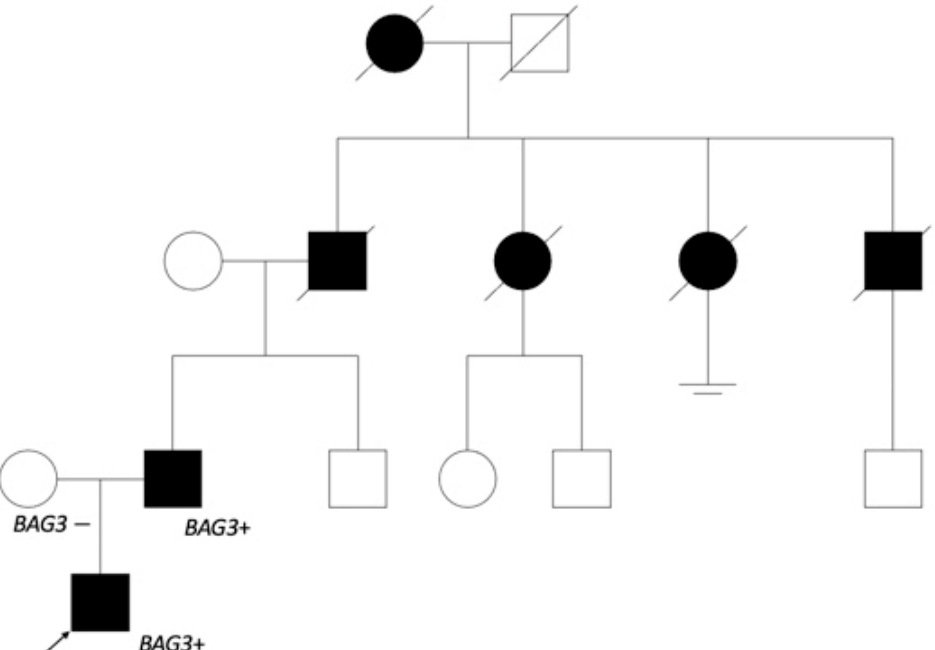
Figure 4. The patient’s genealogy scheme. The patient’s father started having heart insufficiency symptoms at 30 years of age. The grandfather from father’s side and his sisters died of heart disorder about 60 years of age, and the grandfather’s brother at 40 years of age. It is noted that grandfather’s sister started having arrhythmias at a younger age. The great-grandmother also died from a heart disorder. No relevant information from the patient’s mother’s side. Genetic testing was offered to the patient’s father’s brother and his cousins.